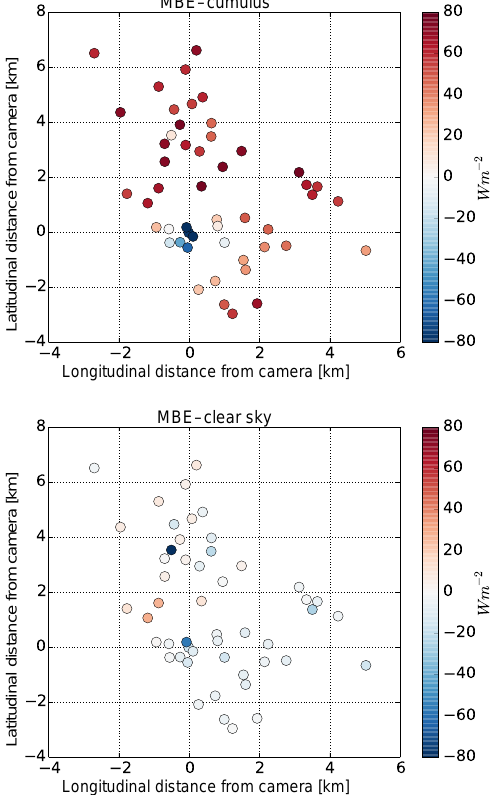
Figure 8. Mean bias error (MBE) of sky imager analysis for each pyranometer and for cumulus cloud type (top) and clear sky condi- tions (bottom).